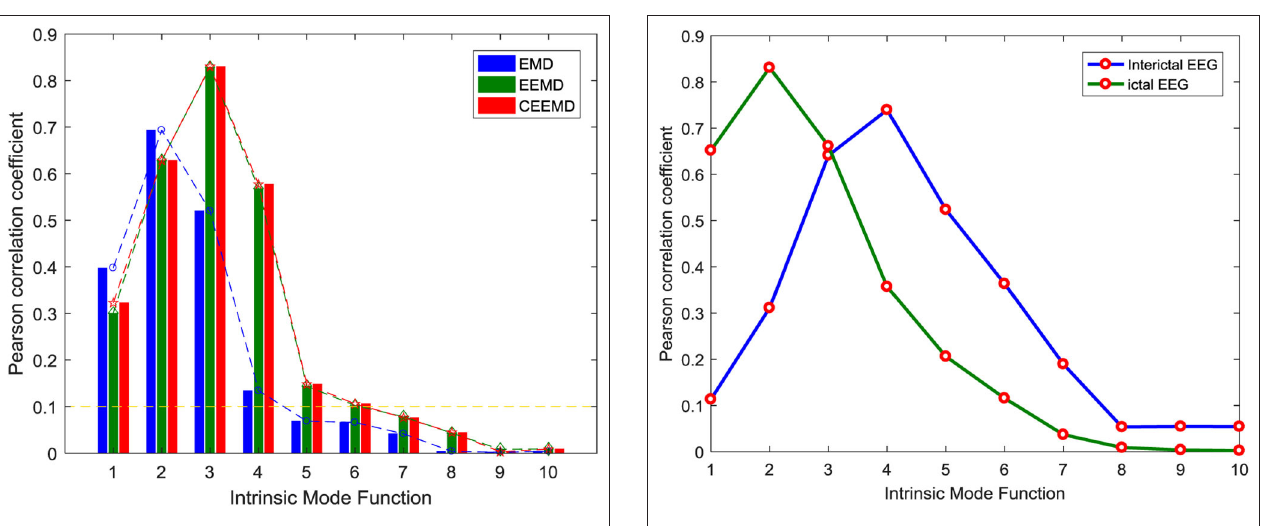
FIGURE 3 | Correlation between IMF and raw signals in different stages of ictal period signals.